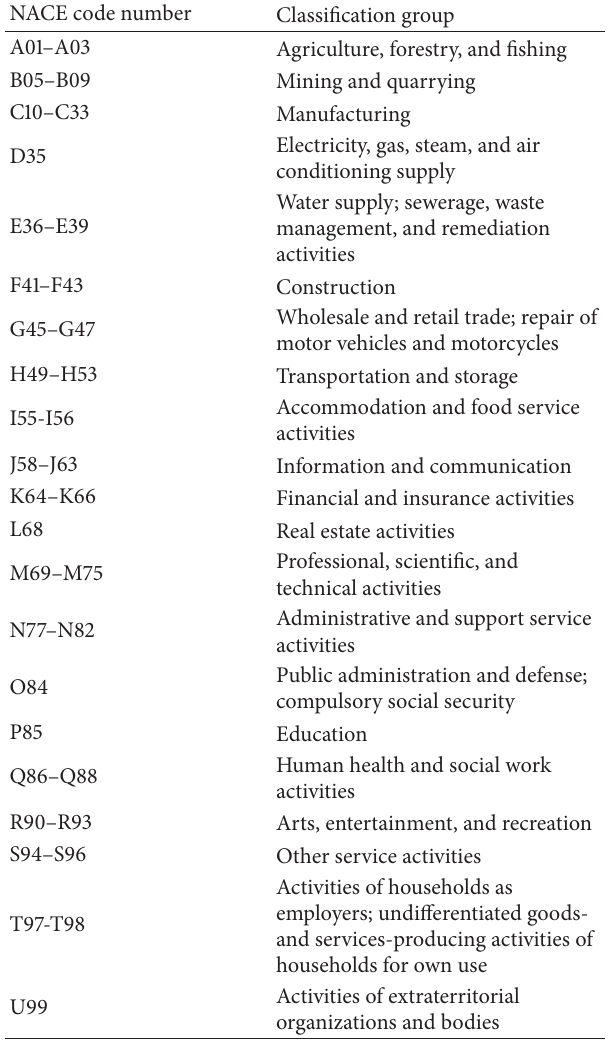
Table 2: Statistical classification of economic activities in the Euro- pean Community, Rev. 2 (2008)